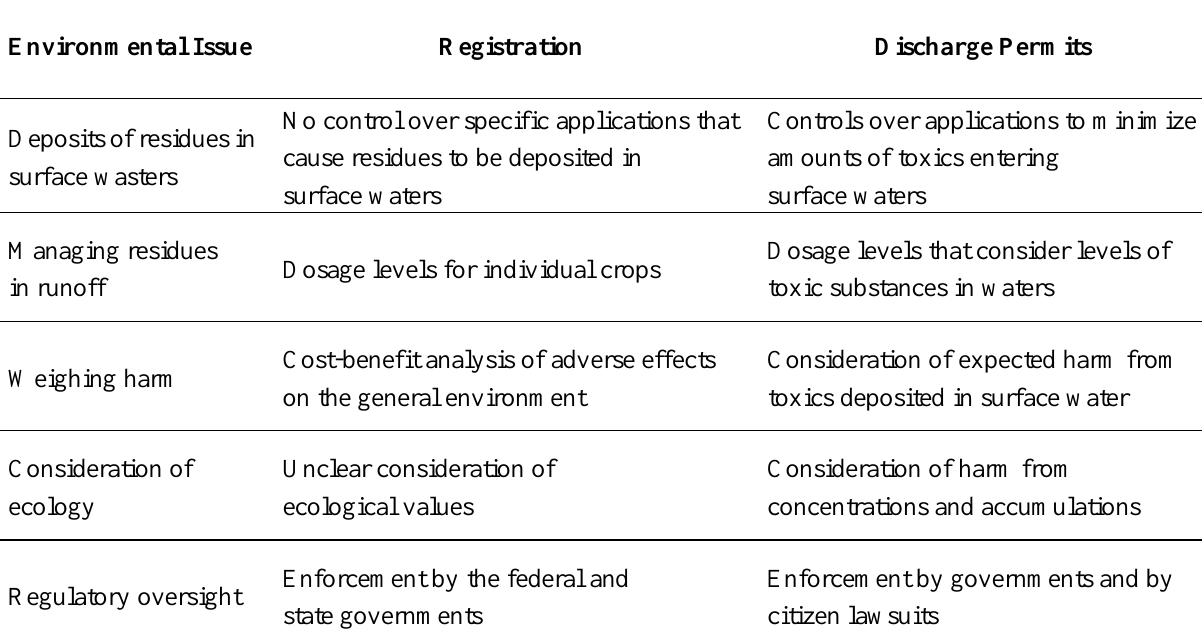
Table 1. Contrasting U.S. registration with discharge